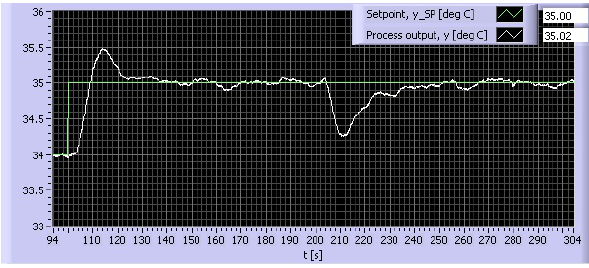
Figure 15: Relay tuning method: Responses in the con- trol